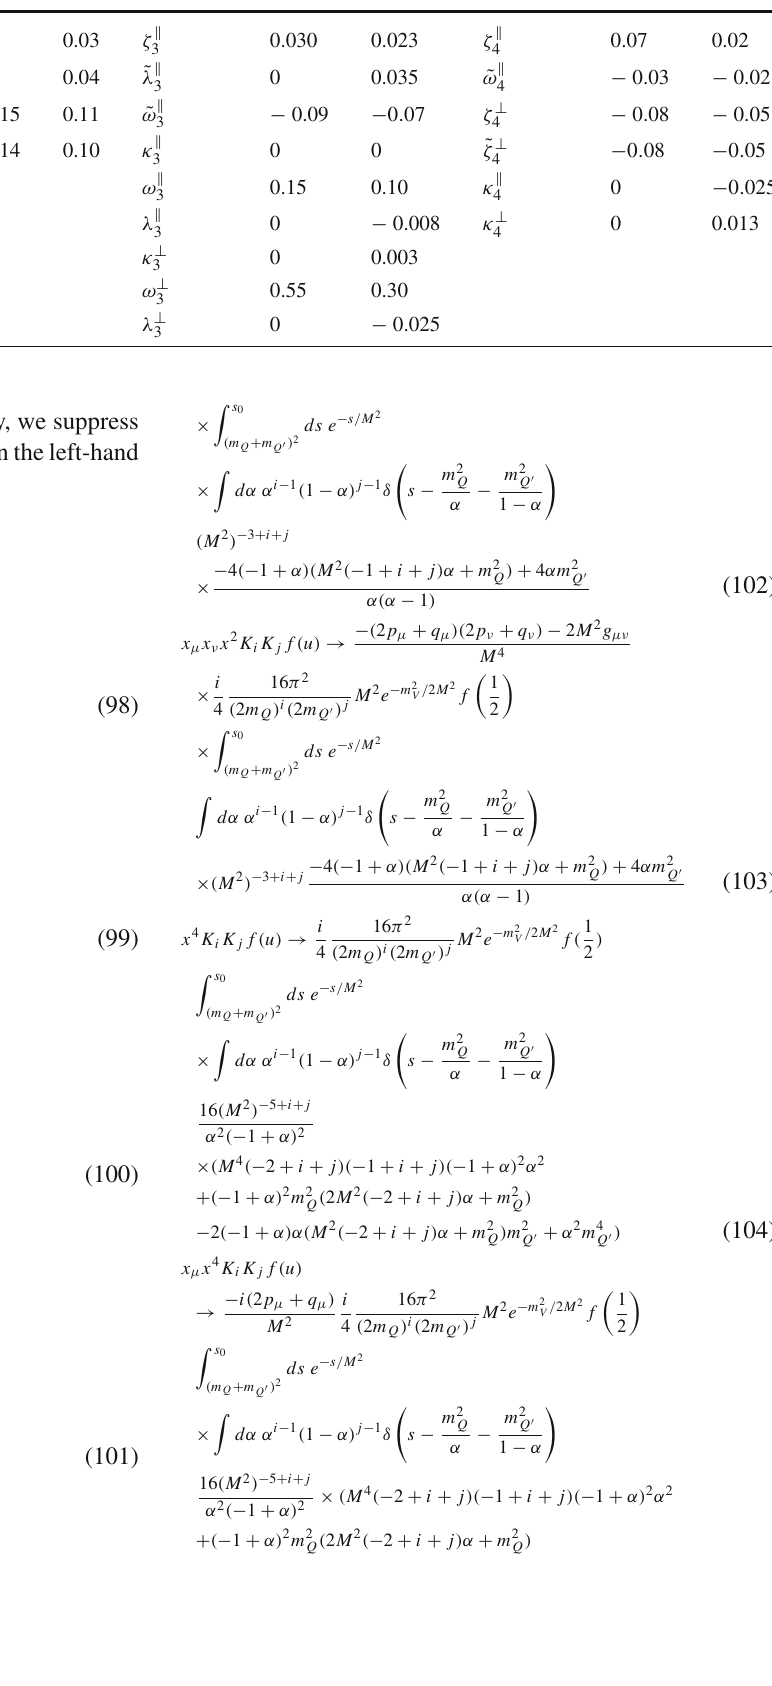
Table 4 The numerical values for the parameters in the DAs for vector mesons ρ and K ∗ . The renormalization scale is μ = 1 GeV